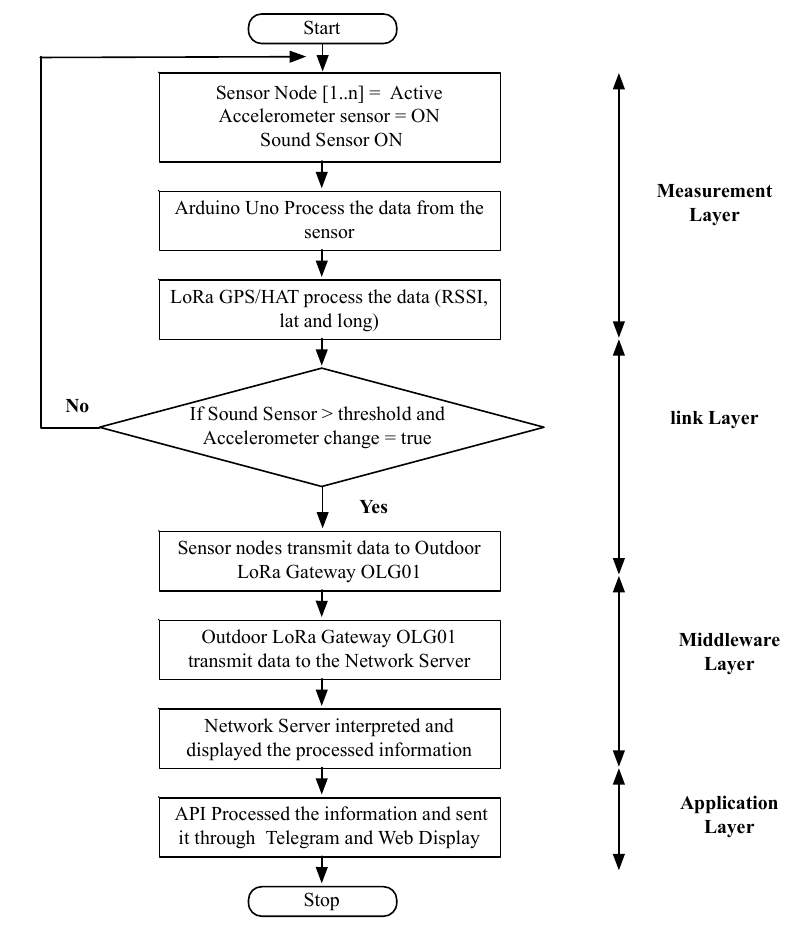
Figure 6. Flowchart of the Proposed System.